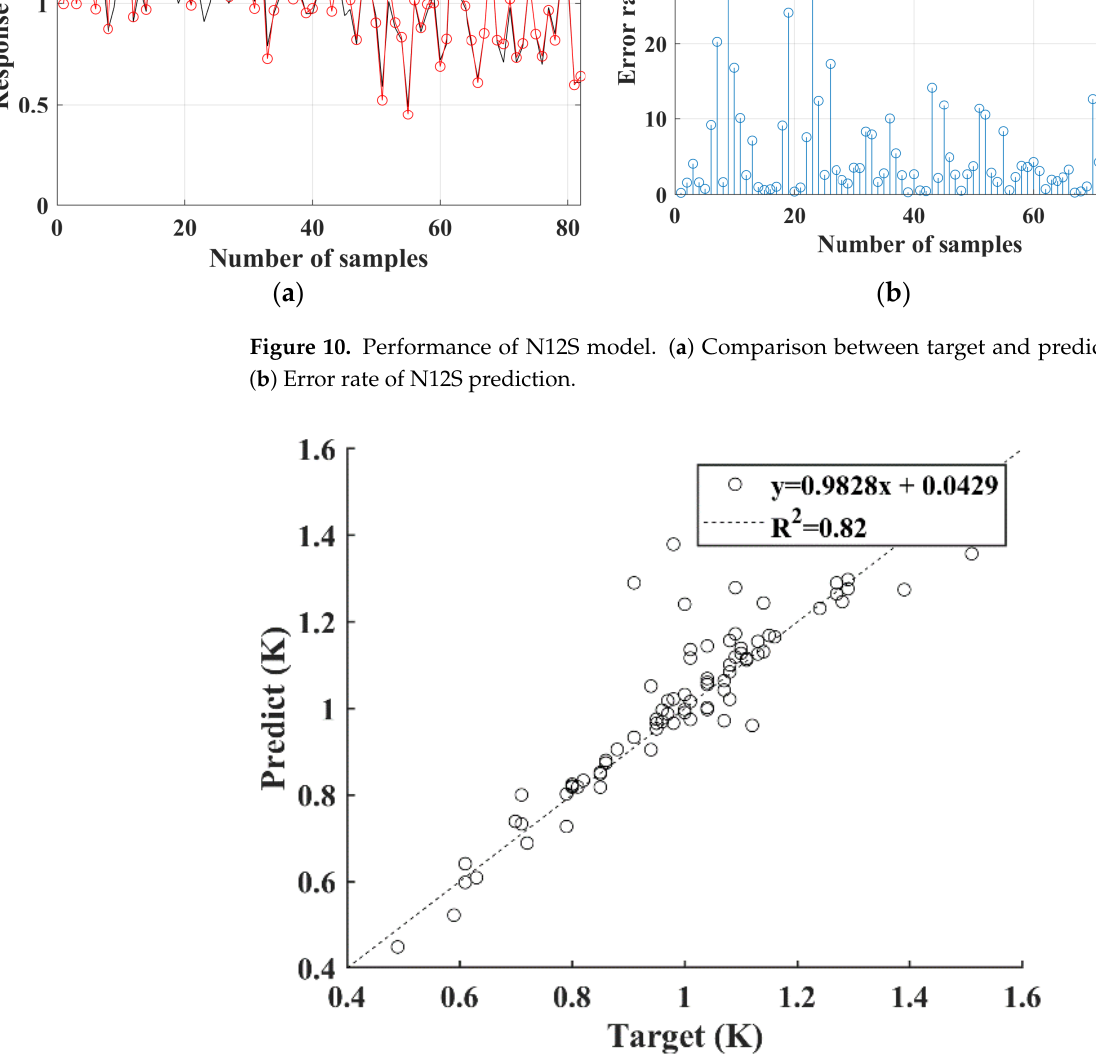
Figure 11. Comparison of target and prediction.